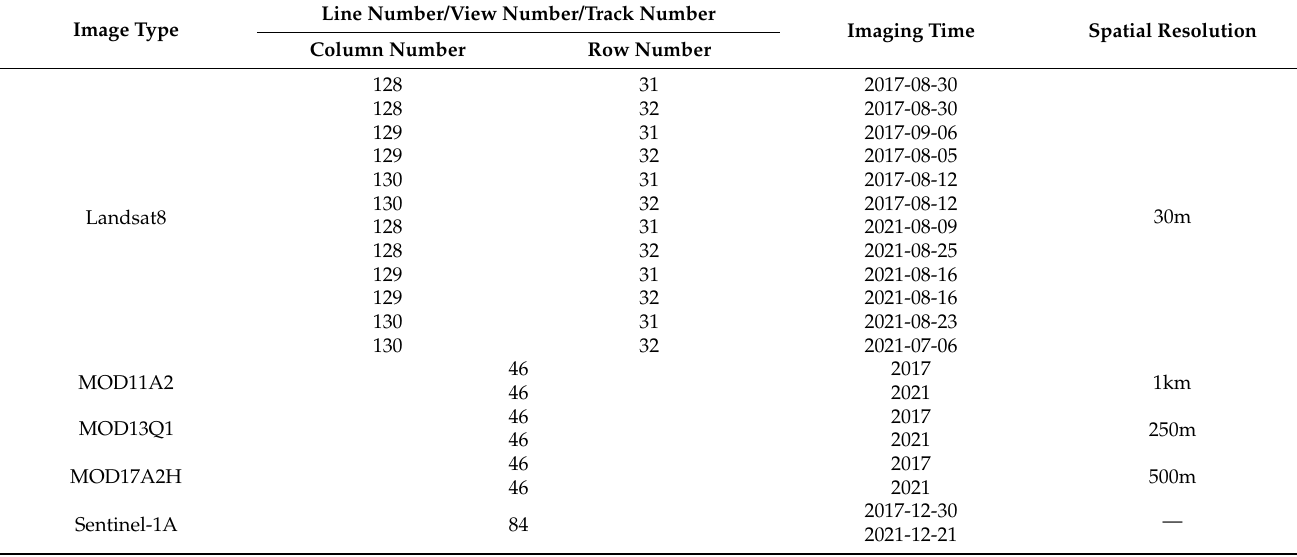
Table 1. Acquisition schedule of remote sensing